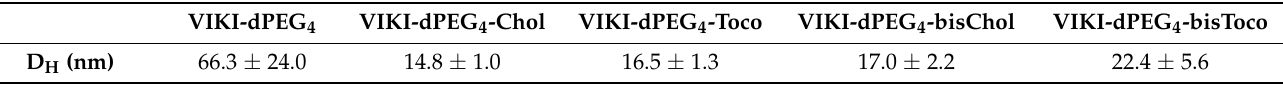
Table 4. DLS number-average hydrodynamic diameter for the peptide aggregates at 20 µ M, in PBS buffer, at 25 ◦ C. Data are presented as mean ±